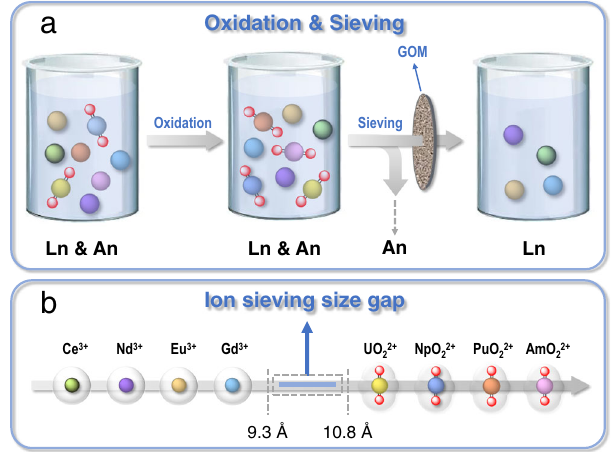
Fig. 1 | Actinides/lanthanides group separation through ion sieving in the membrane.a Schematicdiagramforactinides/lanthanidesgroupseparationbased on the ion-sieving strategy. b Representative lanthanide and actinide ions (details for the size calculation and relevant discussion are provided in Supplemen- tary Note